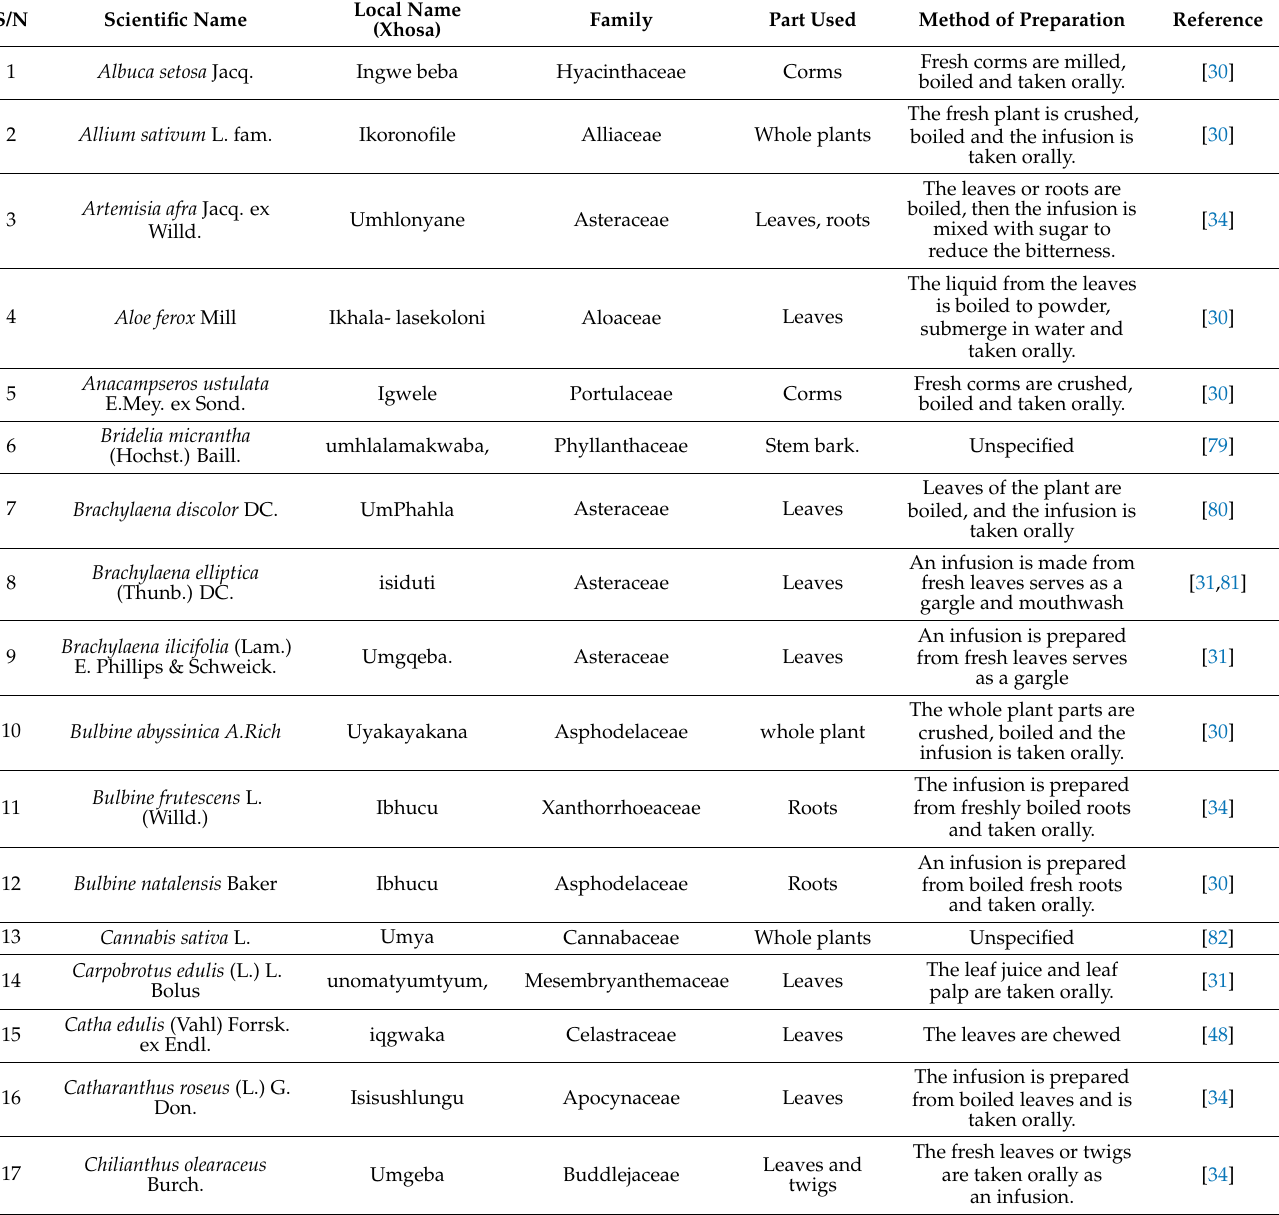
Table 1. List of medicinal plants used to treat diabetes in the Eastern Cape